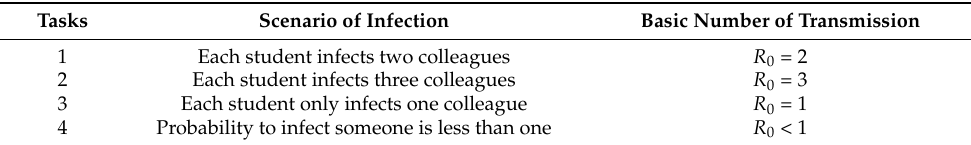
Table 7. Tasks implemented in the Mathematics classes.